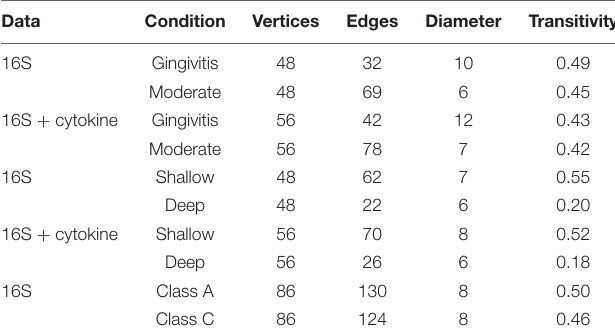
TABLE 5 | Summary statistics of the networks generated from the periodontal treatment (PT) datasets comparing 16S and cytokines based on disease